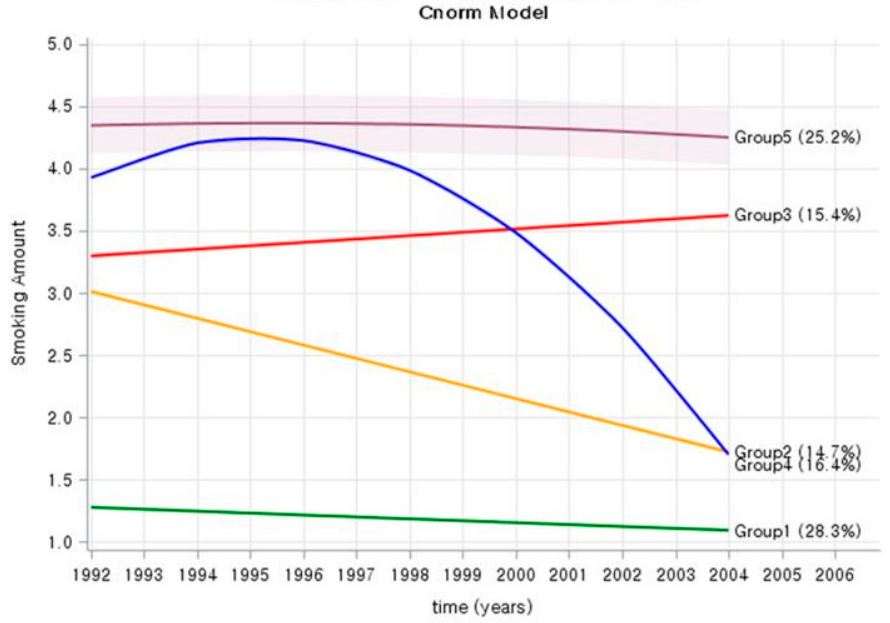
Figure 1. Trajectory group of smoking amounts in Korean young adult men.